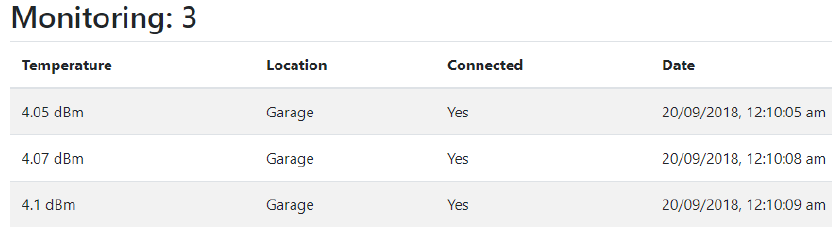
Figure 7. Front-end application featuring SparkFun Simultaneous RFID Reader—M6E Nano board